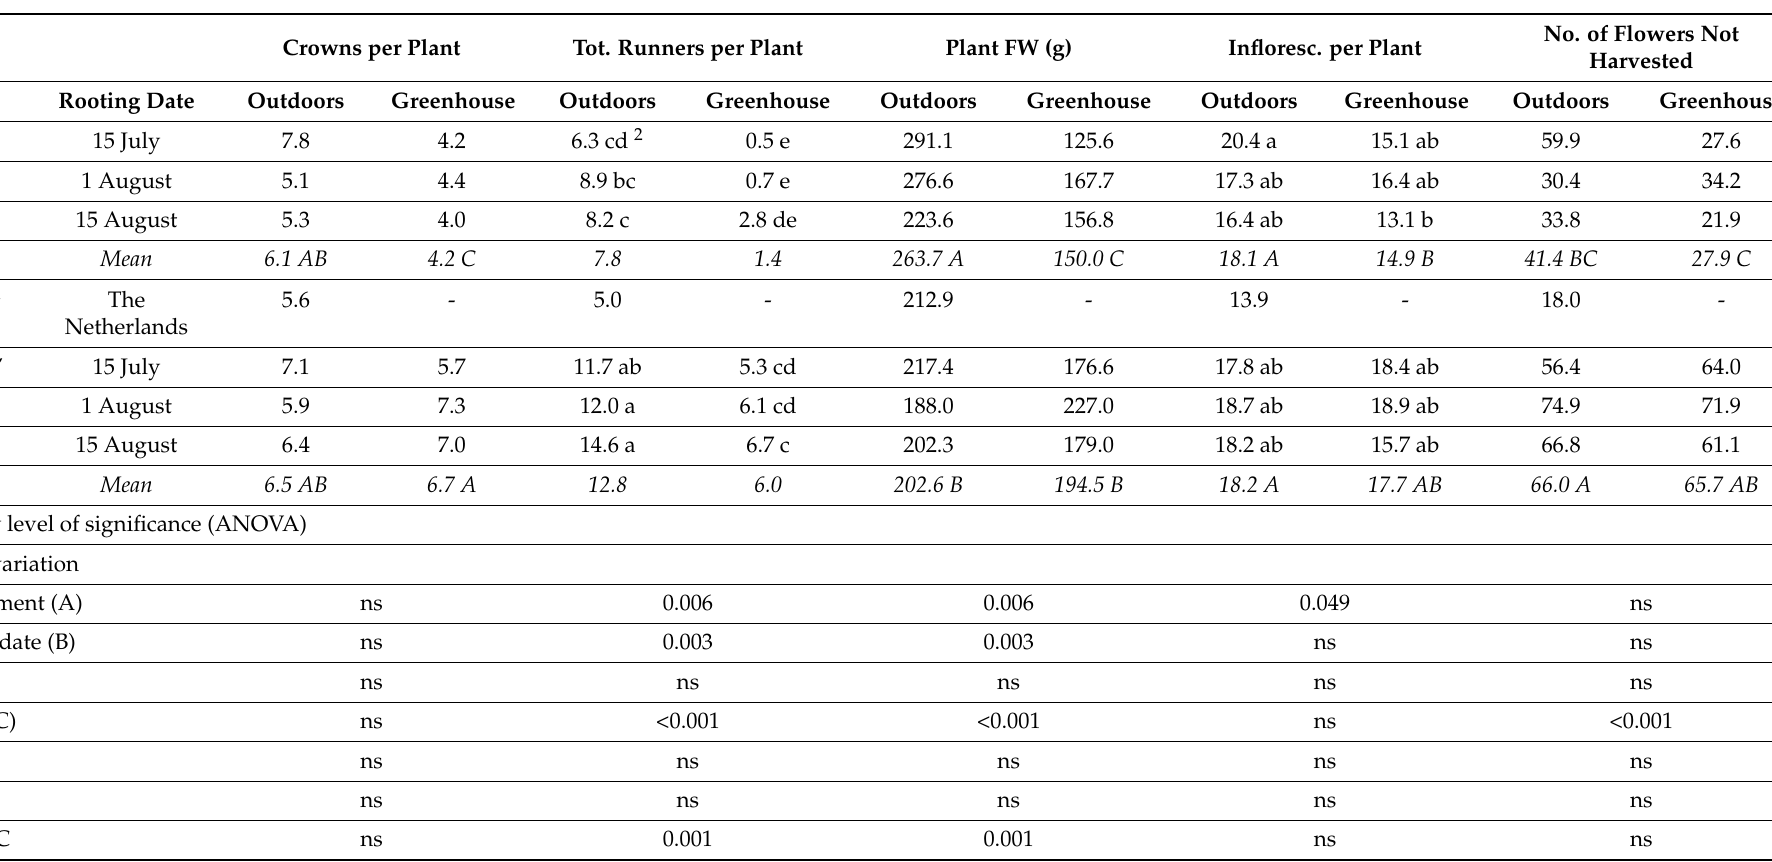
Table 3. Effects of rooting date and raising environment on final plant structure and size of two everbearing strawberry cultivars. Results for imported ‘Favori’ plants are included for comparison. The data were recorded at termination of the harvest on 2 October and represent the means of three replications with three plants of each